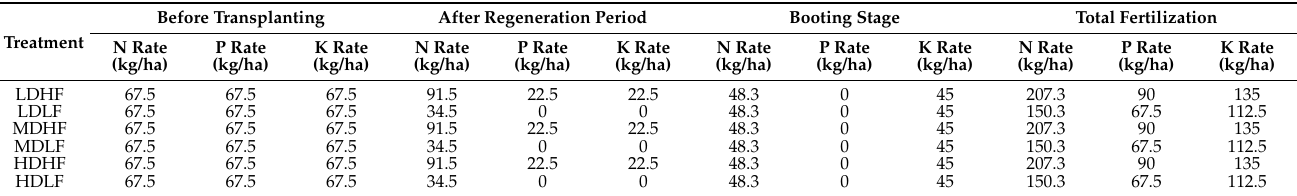
Table 1. Different fertilizer rates and transplanting density treatments in 2019 and